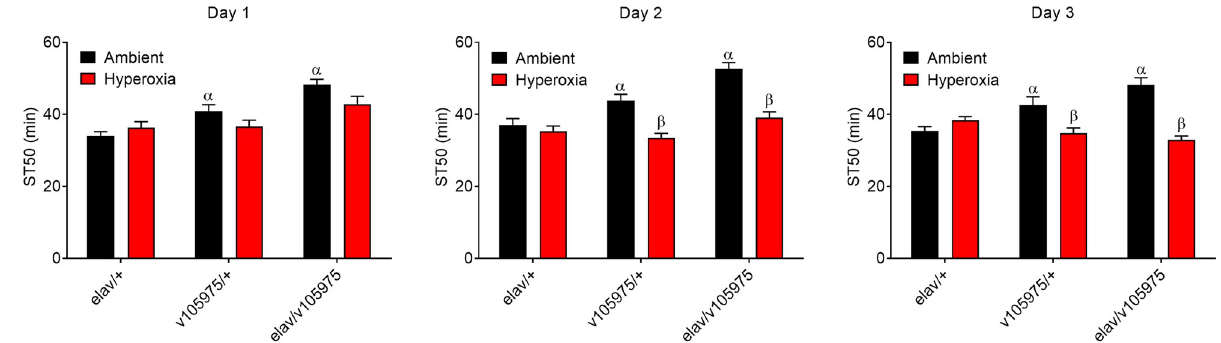
Fig 5. Ethanol sensitivity under hyperoxia. Effect of chronic hyperoxia on acute ethanol sedation. ST50 is the time required for 50% of flies to become sedated. Longer ST50 represent resistance to ethanol sedation. (a) Day 1: Effect of Genotype (p < 0.0001) but not hyperoxia (p = 0.0950) and no interaction (p = 0.0626). α Effect of genotype under ambient conditions: ST50 longer in v105975/+ and elav /v105975 compared to control elav /+ (p < 0.0001–0.0477). (b) Day 2: Effects of hyperoxia (p < 0.0001) and genotype (p < 0.0001) with a significant interaction (p = 0.0021). α Effect of genotype under ambient conditions: ST50 was longer in v105975/+ and elav /v105975 compared to control elav /+ (p < 0.0001–0.0358). β Within genotype, hyperoxia decreased ST50 (p < 0.0001–0.0003). (c) Day 3: Effect of hyperoxia (p < 0.0001) but not genotype (p < 0.0791), and a significant interaction (p = 0.0001). α Effect of genotype under ambient conditions: ST50 was longer in v105975/+ and elav /v105975 compared to control elav /+ (p < 0.0001– 0.0172). β Within genotype, hyperoxia decreased ST50 (p < 0.0001–0.0078). Strain and hyperoxia conditions evaluated with two-way ANOVAs and Bonferroni’s multiple comparison